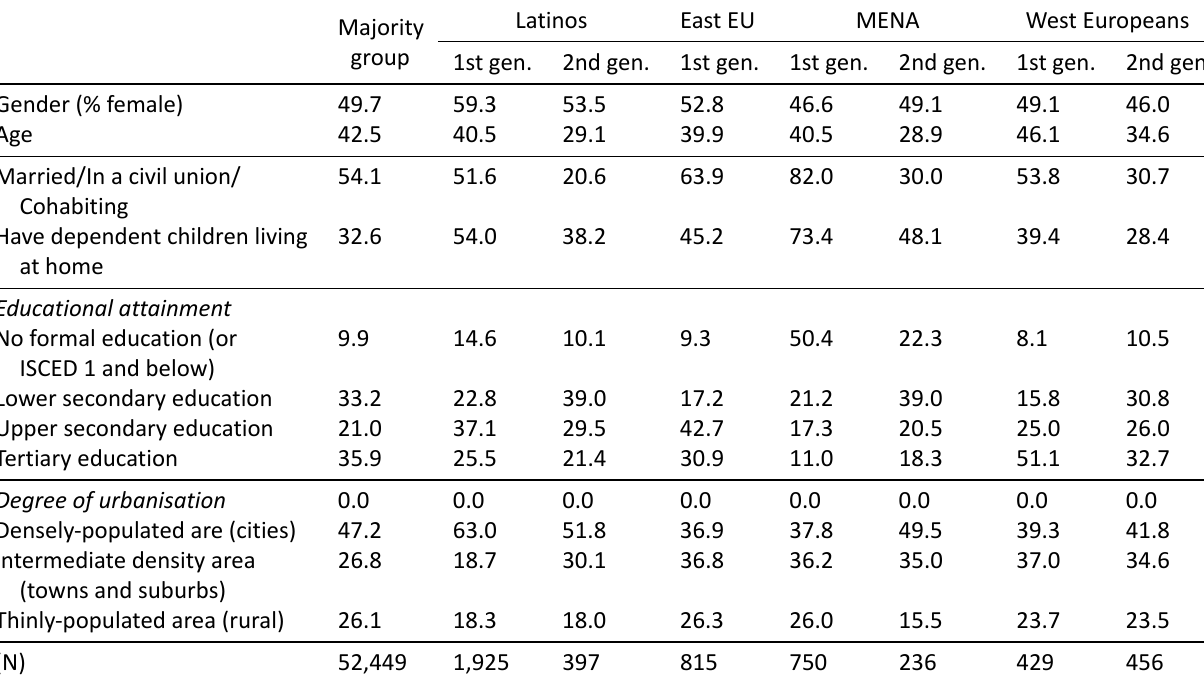
Table 2. Sociodemographic and control variables by gender, ethnicity and generation (%) in